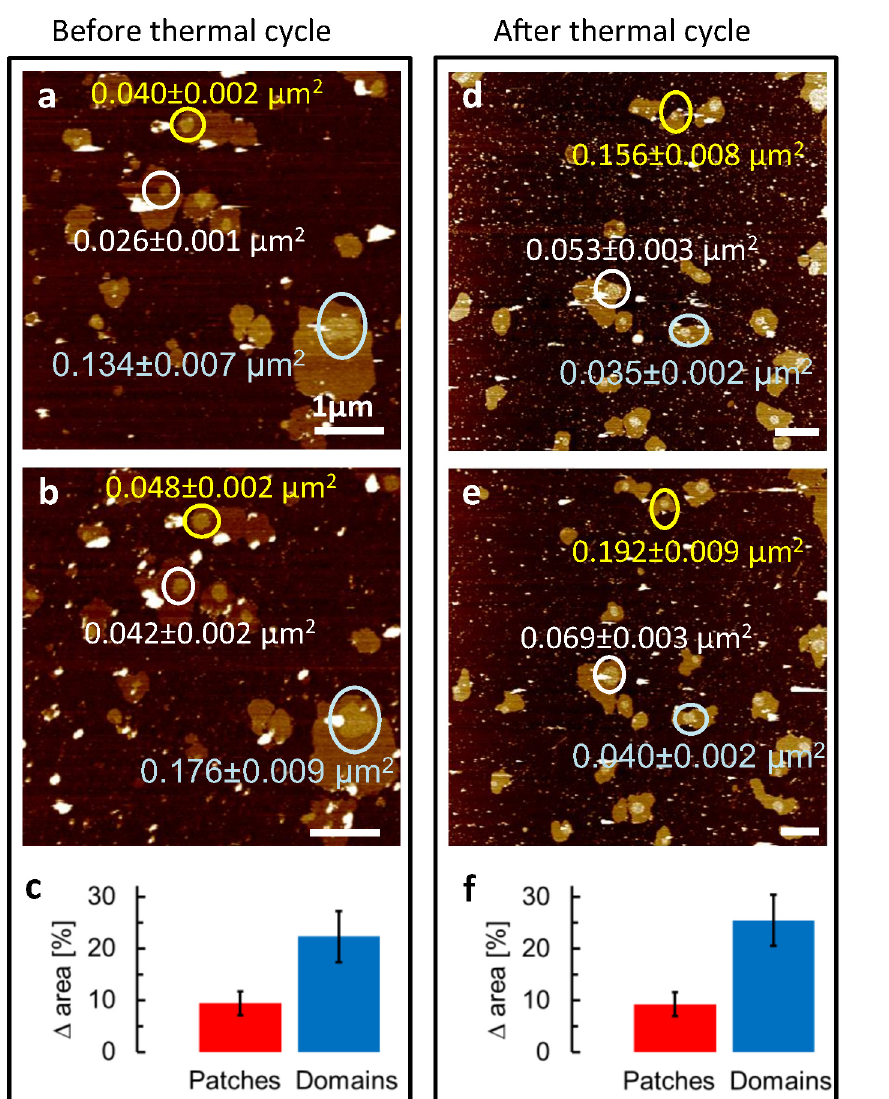
Fig 4. Immunolabelling of microdomains. AFM at room temperature to detect protein content in the microdomains, before (left) and after (right) a thermal cycle (25°C -37°C- 40°C- 25°C). a , Untreated membrane patches were incubated with anti flotillin-1 antibodies. b , After 60 min of incubation, the area of the microdomains protruding from the membrane patches had increased (see differently colored circles for individual examples). c , Histogram of the surface area increase for membrane patches and microdomains after 60 min antibody incubation. d, e, f , As (a, b, c), but for membrane patches that have undergone a thermal cycle prior to the immunolabeling. Student's t-test for the difference between relative increases of patch and microdomain areas: p < 0.01 in both (c) and (f). Horizontal scale bar: 1 μ m; vertical (color) scale: 9 nm in the four AFM